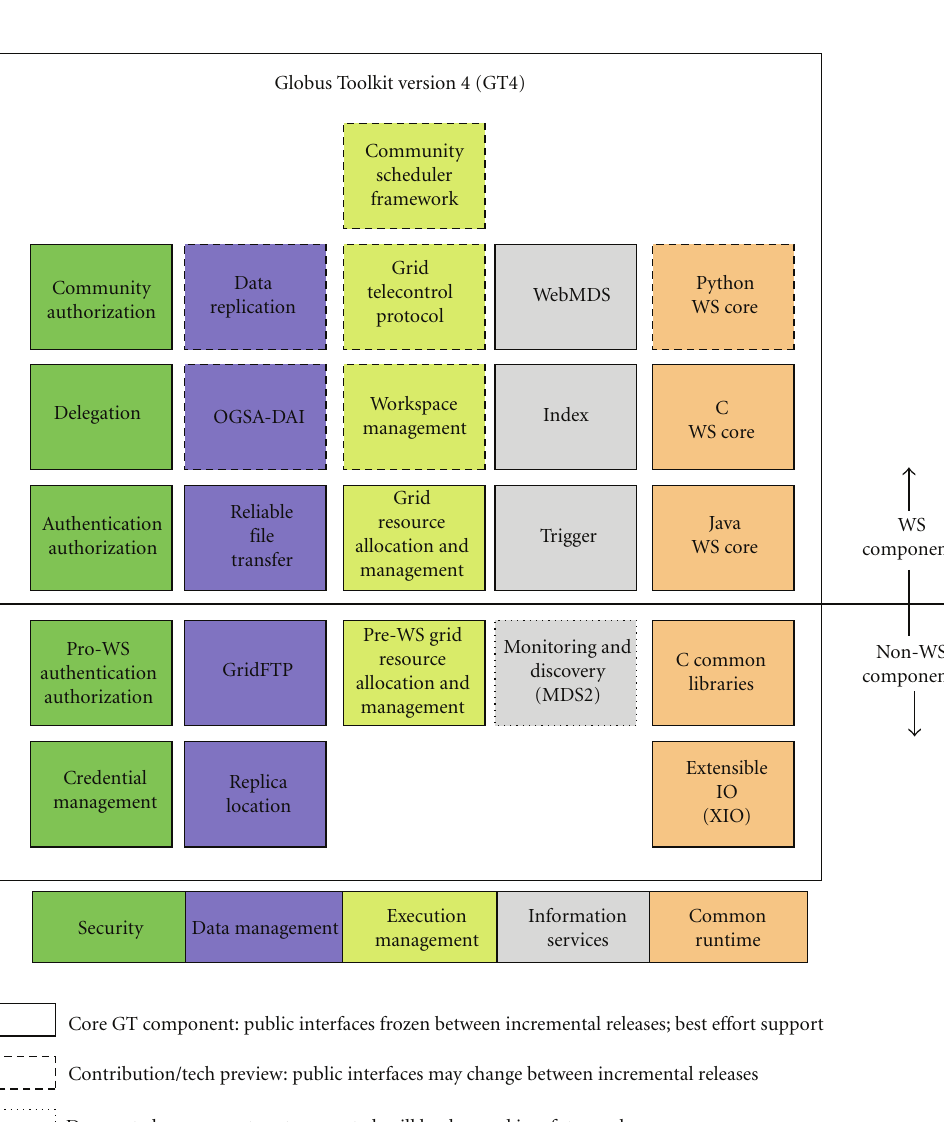
Figure 5: GT4 component